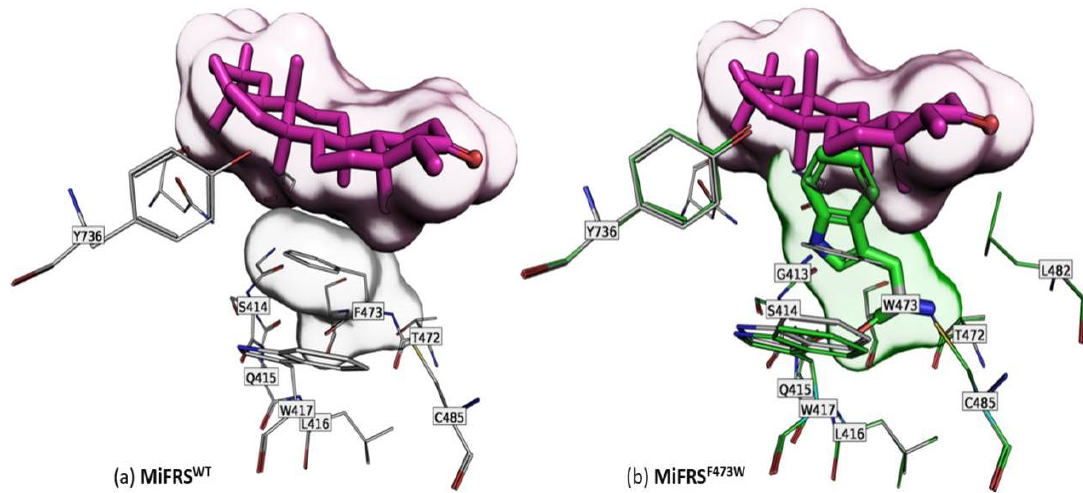
Figure 4. Secondary alignment (or side-by-side representation) of wild protein ( Mi FRS) (gray-stick carbons) with the Mi FRS Phe473Trp mutant (green-stick carbons). The surface highlights the volume adopted by the friedelin molecule in the catalytic cavity. The green stick indicates the mutated residue. ( a ) Favorable interaction between the wild-type Phe473 residue and substrate. ( b ) Steric bulk of Trp473 residue at the active site of MiFRS Phe473Trp . Interaction between Trp417 and Trp473 residues is favorable, which blocks the substrate entrance inside the pocket.